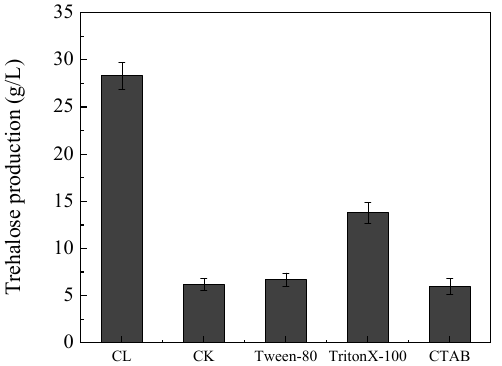
Figure 2. The effects of permeabilization agents on cell permeabilization. CL represents trehalose production by crude cell lysates; CK represents trehalose production by cells without permeabilization. The error bars represent the standard deviation of three independent replicates.